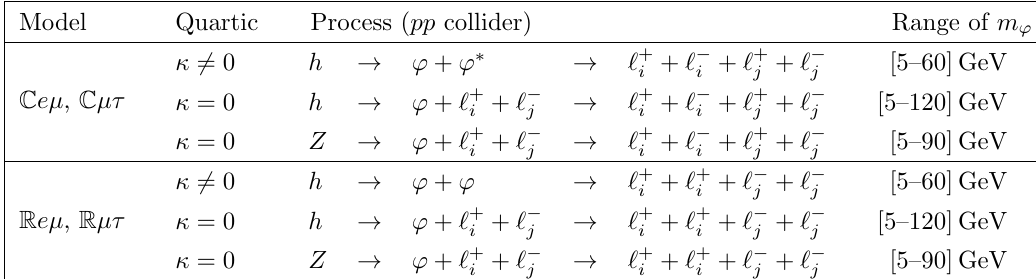
Table 2 . The di(cid:11)erent channels considered in our analysis, along with the ranges of the masses for ’ . For (cid:20) = 0, we ignore the interference between the h - and Z -mediated channels.